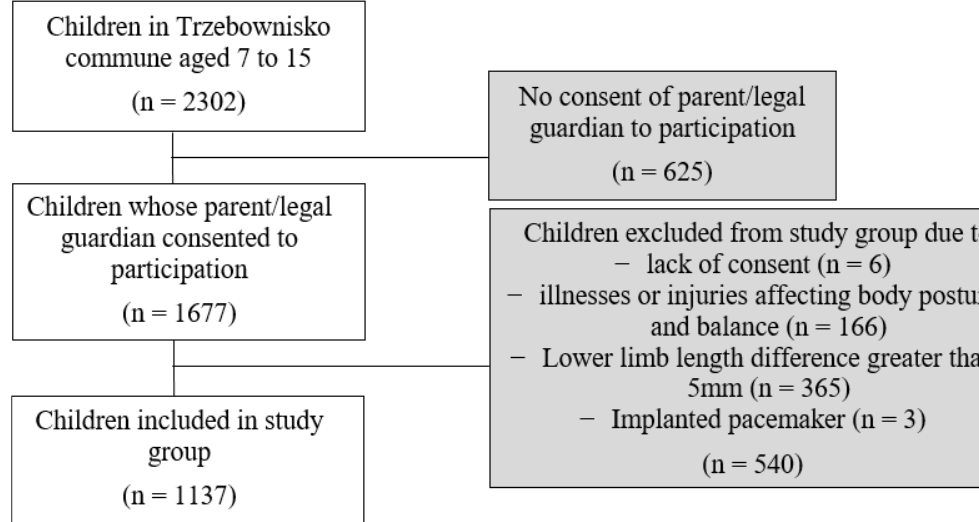
Figure 1. Flow chart of participants.